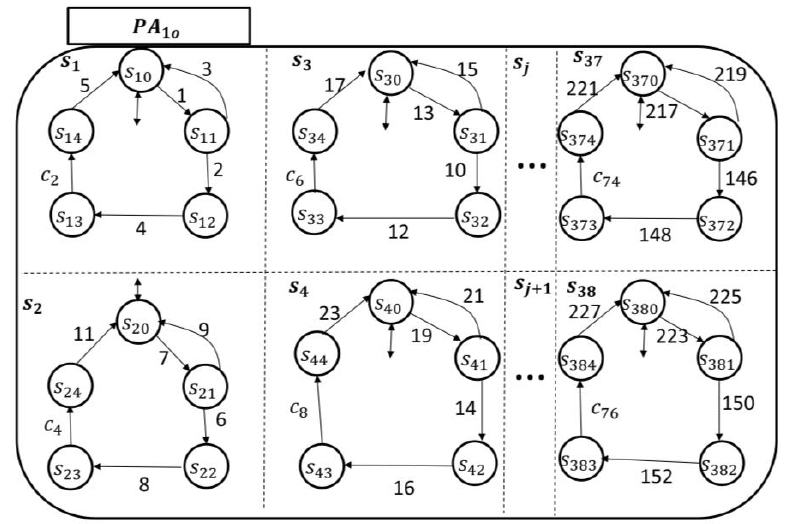
Figure 7. Patient automaton transitional